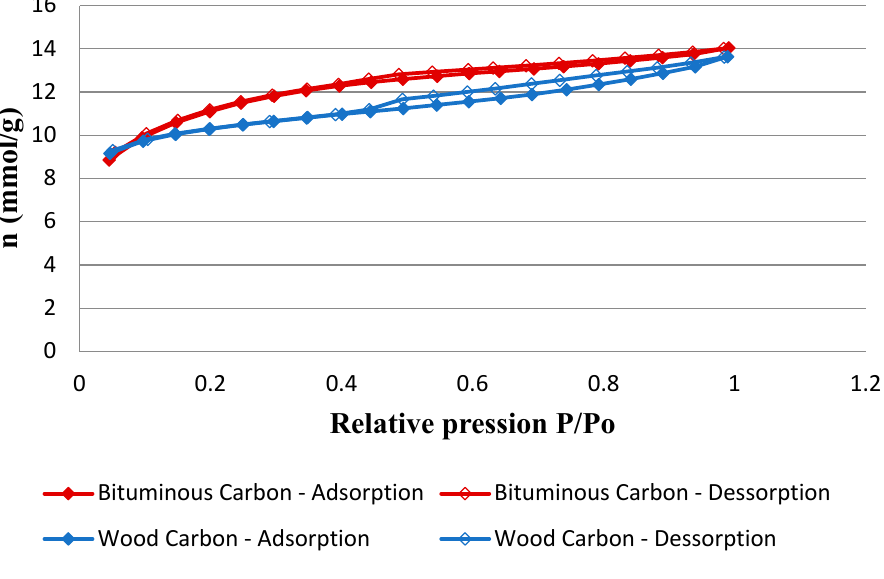
Figure 5. N 2 adsorption isotherms for the studied carbons.